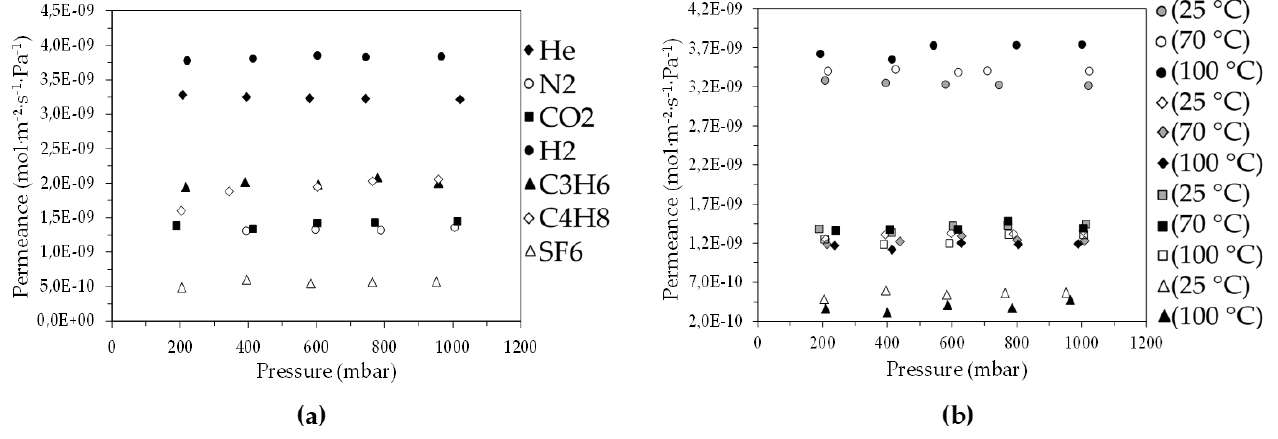
Figure 7. Permeance of ( a ) Ηe, N 2 , CO 2 , Η 2 , C 3 H 6 , C 4 H 8 , and SF 6 gases at 25 °C and ( b ) Ηe, Ν 2 , CO 2 , and SF 6 gases at 25, 70, and 100 ◦ C, through the CM4 membrane, as a function of the